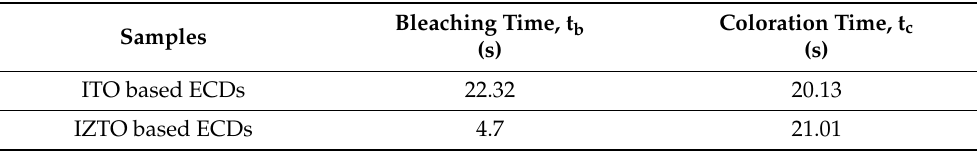
Table 4. The switching response times of the coloration and bleaching states for IZTO-based and ITO-based ECDs.